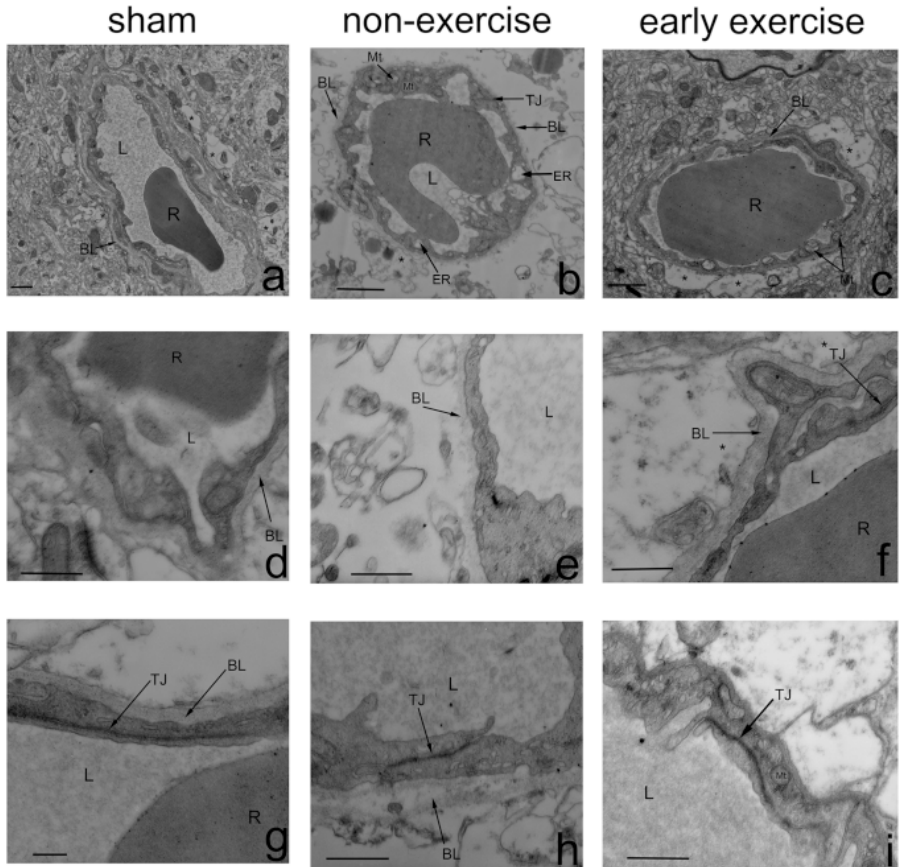
morphology. c , f and i : In the EE group, blood vessels were slightly shrunken, TJs and basement membranes were intact and swelling of astrocytic perivascular processes was observed. TJ: tight junction; * : astrocyte end-foot; L: capillary lumen; R: a red cell; BL: basal lamina; ER: endoplasmic reticulum. Scale bars: a–c,1 µm; d–i, 0.5